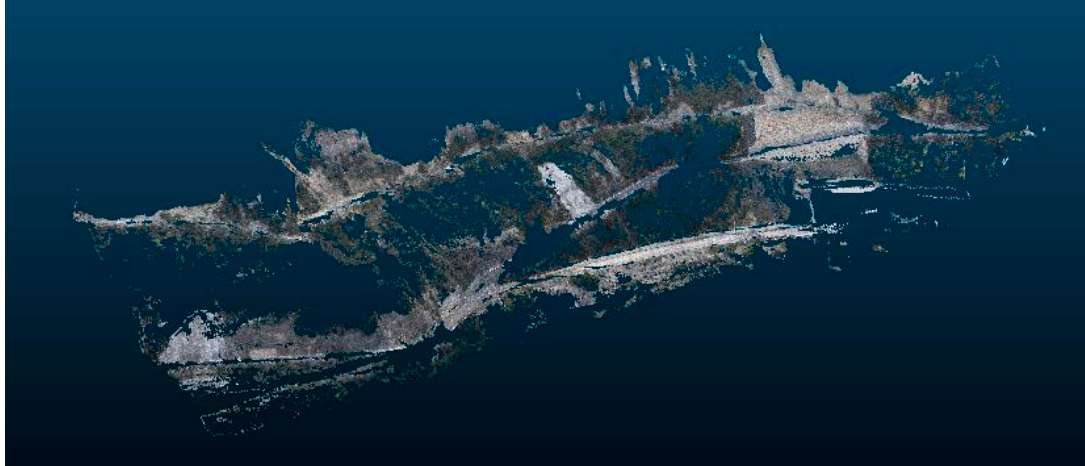
Figure 12. “Closest points set” tool applied to CRP point cloud, taking the MMS point cloud as a reference.